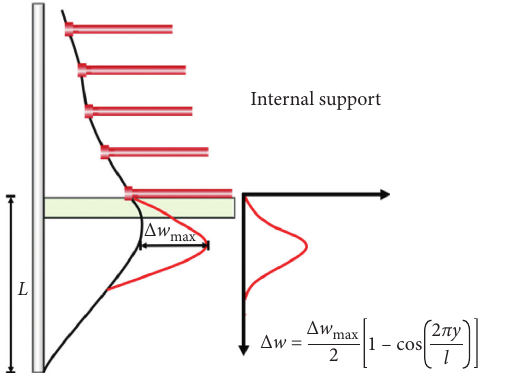
Figure 4: Increment of the horizontal displacement of the internal support foundation